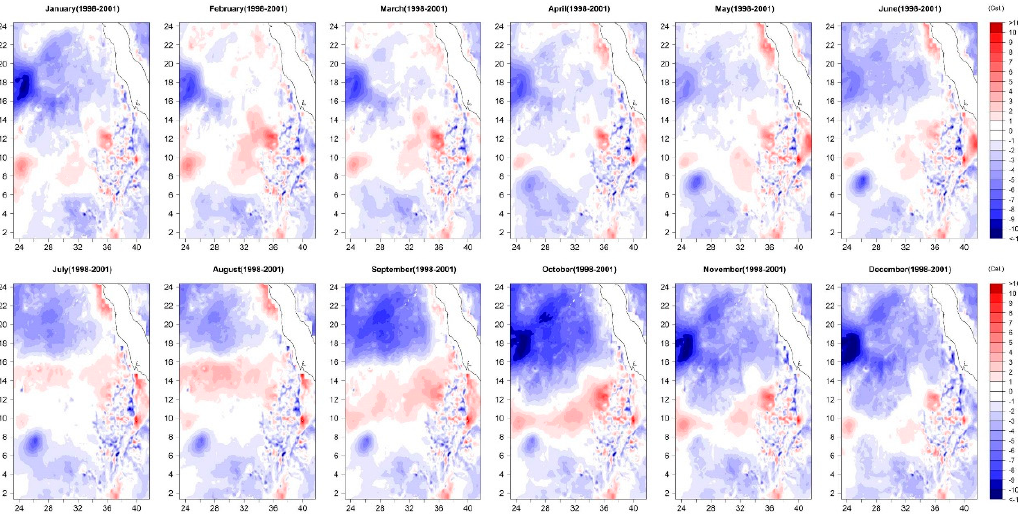
Figure 6. Bias (data obtained from the WRF simulation—data from the UDEL dataset) for the average monthly surface air temperature over the ENB for all the months during the period 1998–2001, Longitude on the horizontal axis and latitude on the vertical axis.